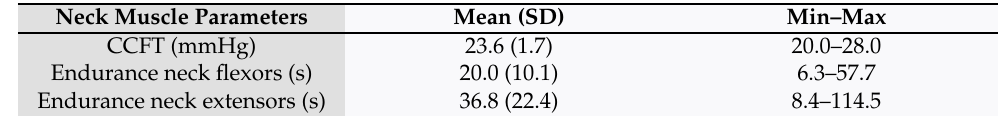
Table 2. Functional measures of the neck muscles.